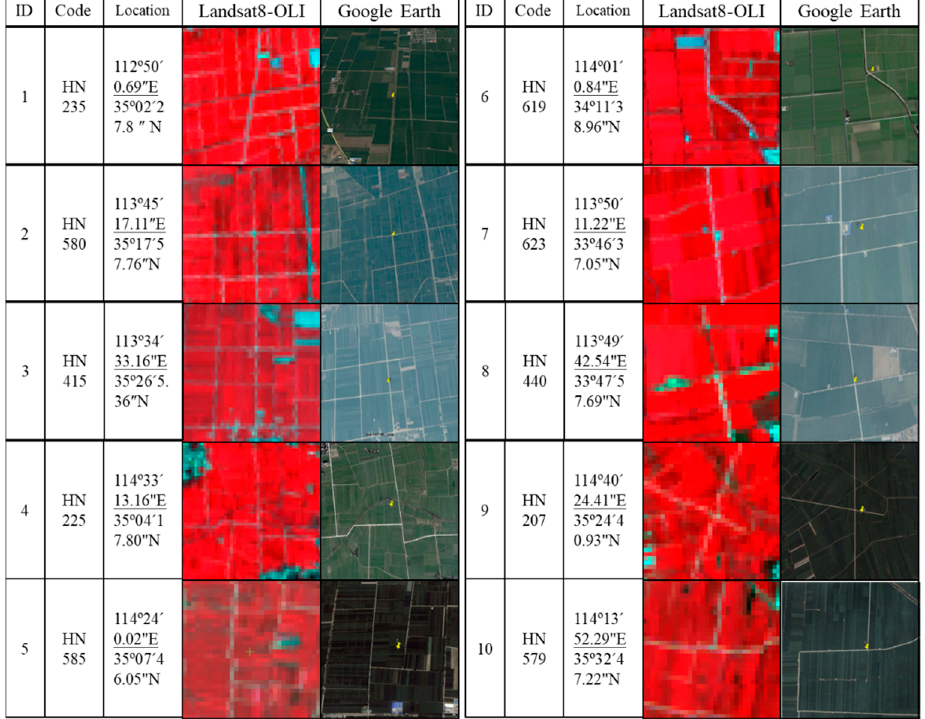
Figure 2. Satellite image of the representative project region of the general survey in HSF construc-